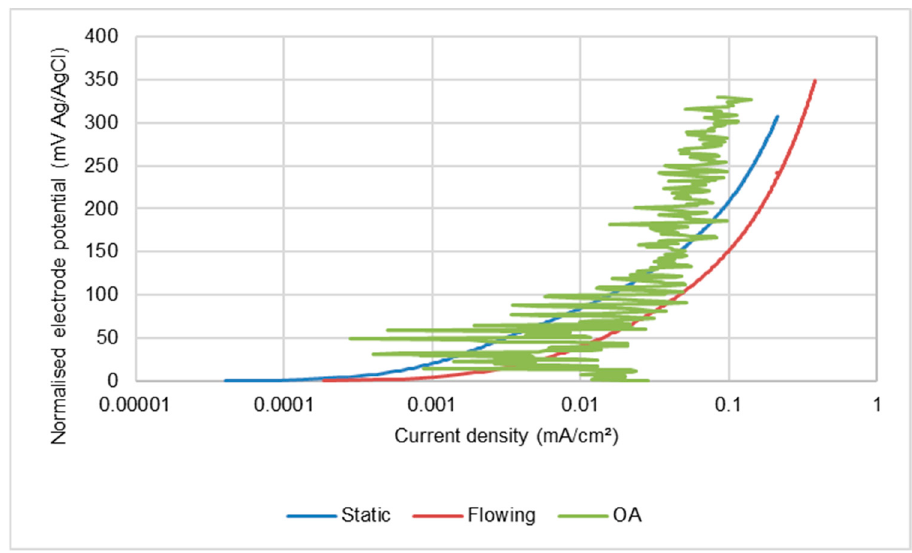
Figure 16. Comparison of anodic polarisation behaviour in 10% NaCl of UNS S31600 alloy in outer zone of SLEC specimen with those in static and LEC conditions.